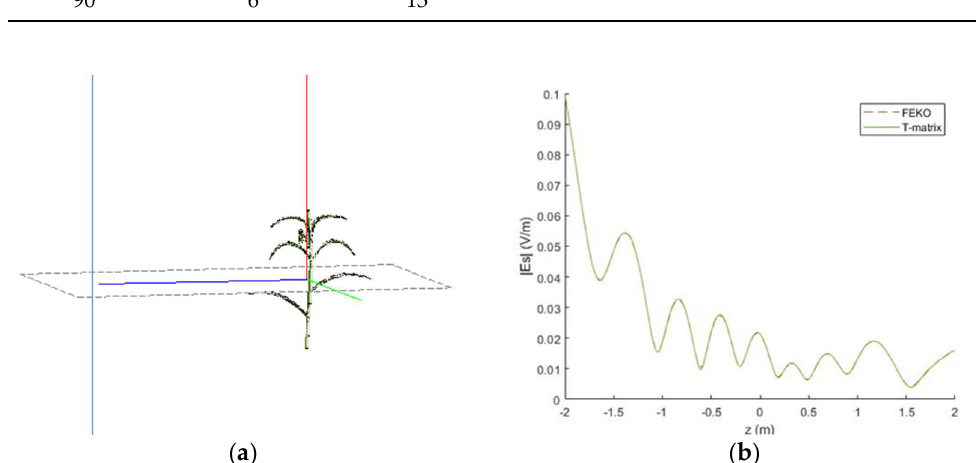
Figure 5 . ( a ) Single corn plant in the simulation, line in ( a ): (cid:1876) = 2 m,(cid:1877) = 0,(cid:1878) = −2 m to 2m ; 35 Figure 5. ( a ) Single corn plant in the simulation, line in ( a ): x = 2 m, y = 0, z = − 2 m to 2 m; 35 points points for (cid:2016) (cid:3046) and (cid:2016) (cid:3036) = 140° , (cid:2038) (cid:3036) = 0° . ( b ) Scattered field for a single corn plant as a function of z for θ s and θ i = 140 ◦ , φ i = 0 ◦ . ( b ) Scattered field for a single corn plant as a function of z along the along the blue line in Figure 5a. blue line in Figure